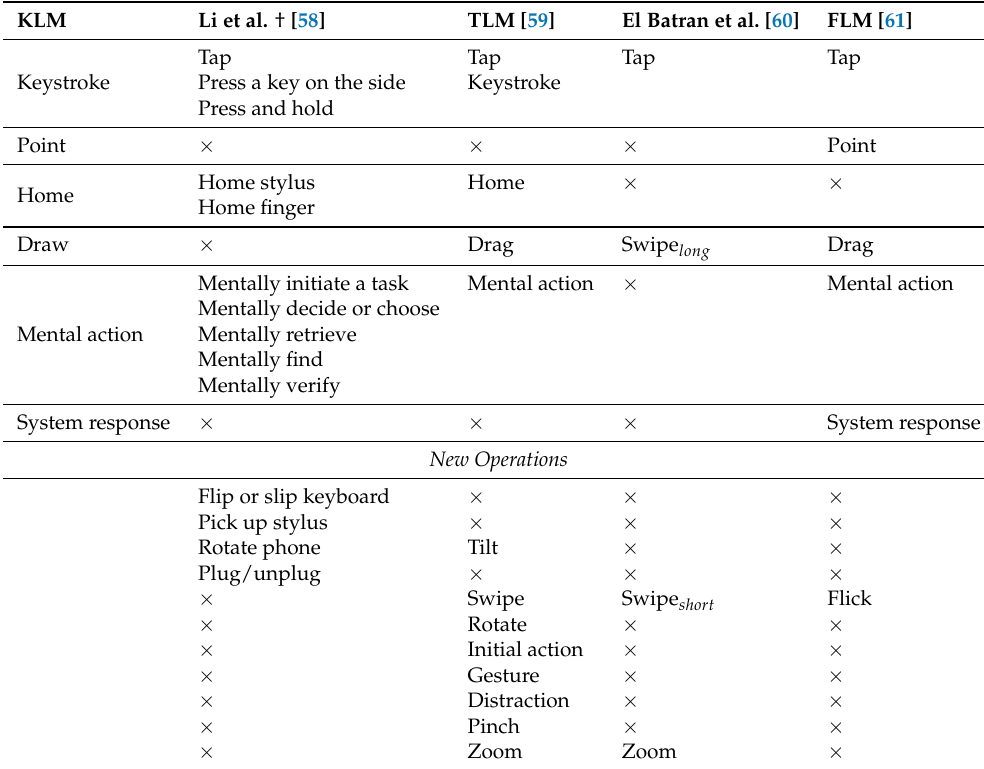
Table 2. Revised versions of the KLM for touch-based smartphones. The models are presented in relation to the original KLM [27]. It should be noted that Li et al. [58] revised model considers the use of a stylus for interaction. KLM Li et al. † [58] TLM [59] El Batran et al. [60] FLM